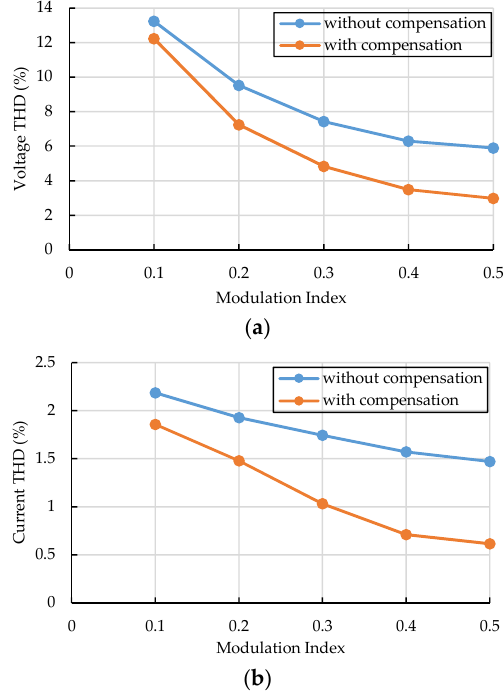
Figure 18. Experimental voltage and current THDs under different load condition ( a ) voltage THD; ( b ) current THD.